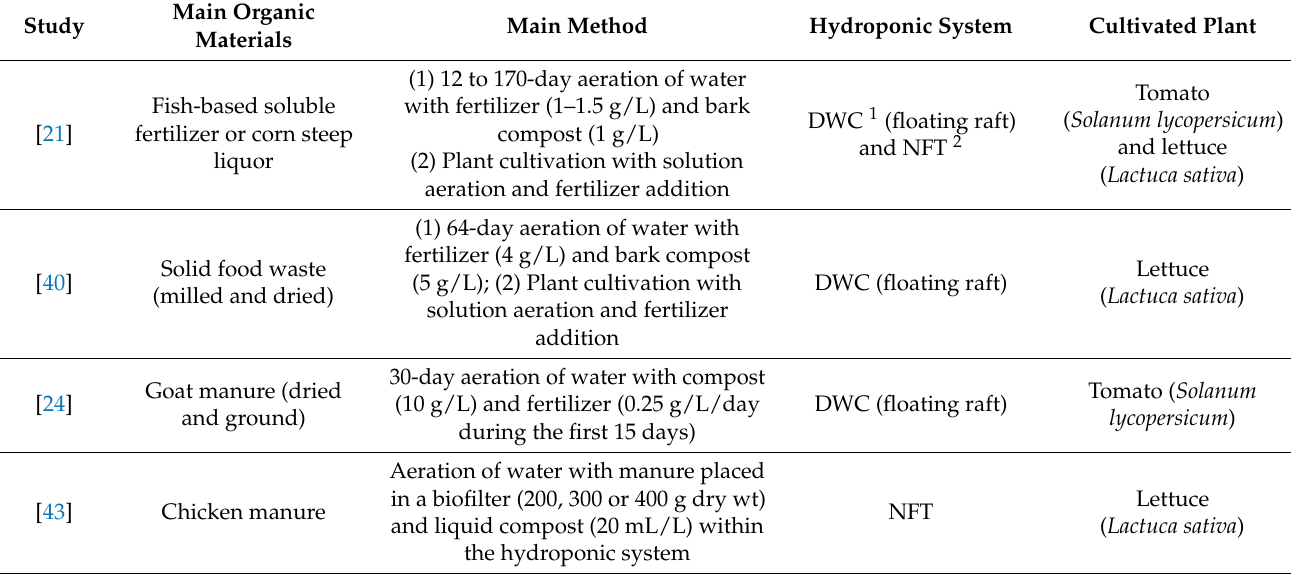
Table 4. Main organic materials and method of aerobic degradation for the production of nutrient solution used in different types of